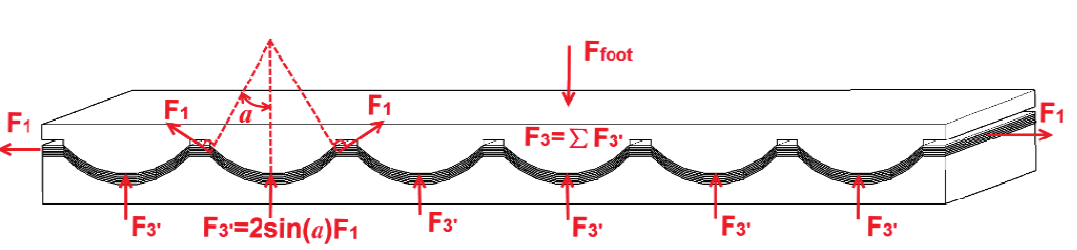
against the upper plate is produced by the PVDF 3